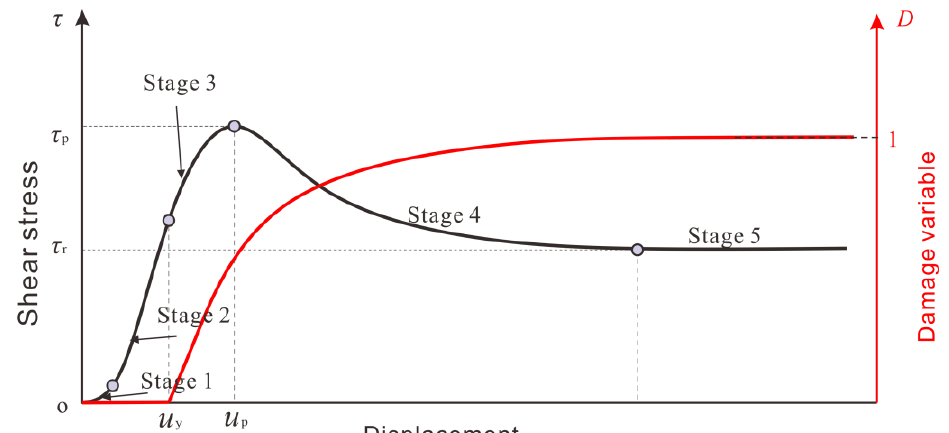
Figure 2. Shear stress–shear displacement curve and damage evolution curve of the slip zone soil in the whole shear process. The damage variable D can define the damage degree of the soil. The damage variable of 0 indicates that the soil is not damaged, and the damage variable of 1 indicates that the soil is completely damaged.